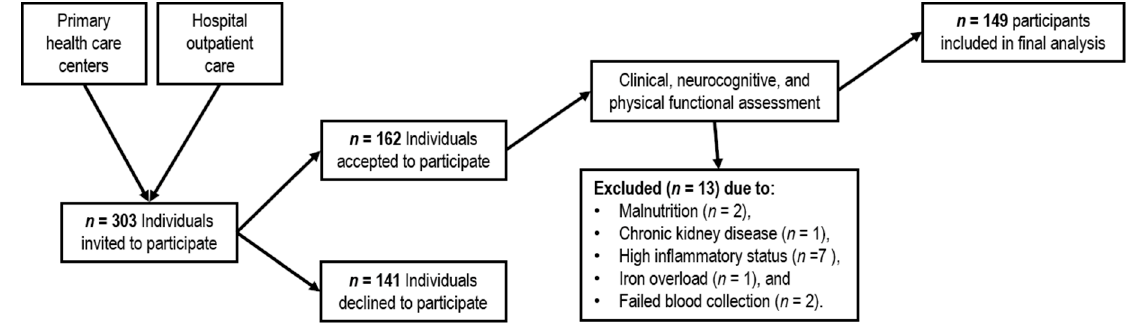
Figure 1. Schematic representation of recruitment and inclusion of participants in the study.